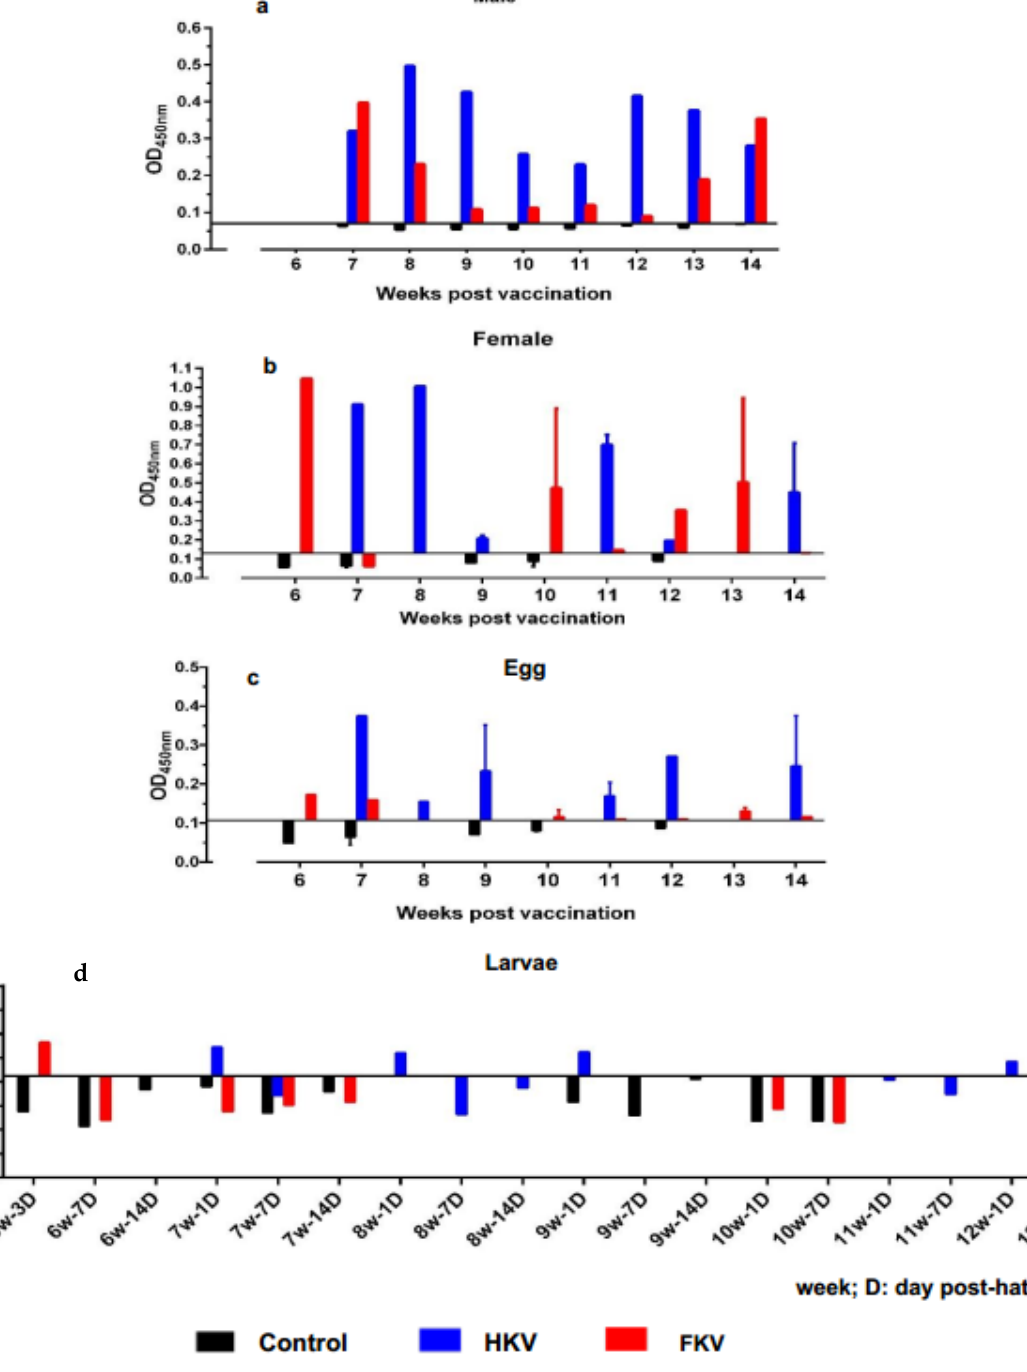
Figure 2. TiLV-specific IgM levels (OD 450 ) from 6 to 14 weeks post primary vaccination in ( a ) vaccinated male broodstock (diluted 1:1024, n = 1 per treatment weekly), ( b ) vaccinated female broodstock (diluted 1:1024, n = 1–2 per treatment weekly), ( c ) egg supernatant (diluted 1:8, n = 1–2 per treatment weekly) and ( d ) larval supernatant (diluted 1:2, n = 1 per treatment at different sampling time points). The OD 450 values were compared with significantly statistical cut-off values. HKV, FKV, and Control mean that the broodstock, eggs or larvae originate from the heat-killed vaccine group, the formalin-killed vaccine group and the control group, respectively.